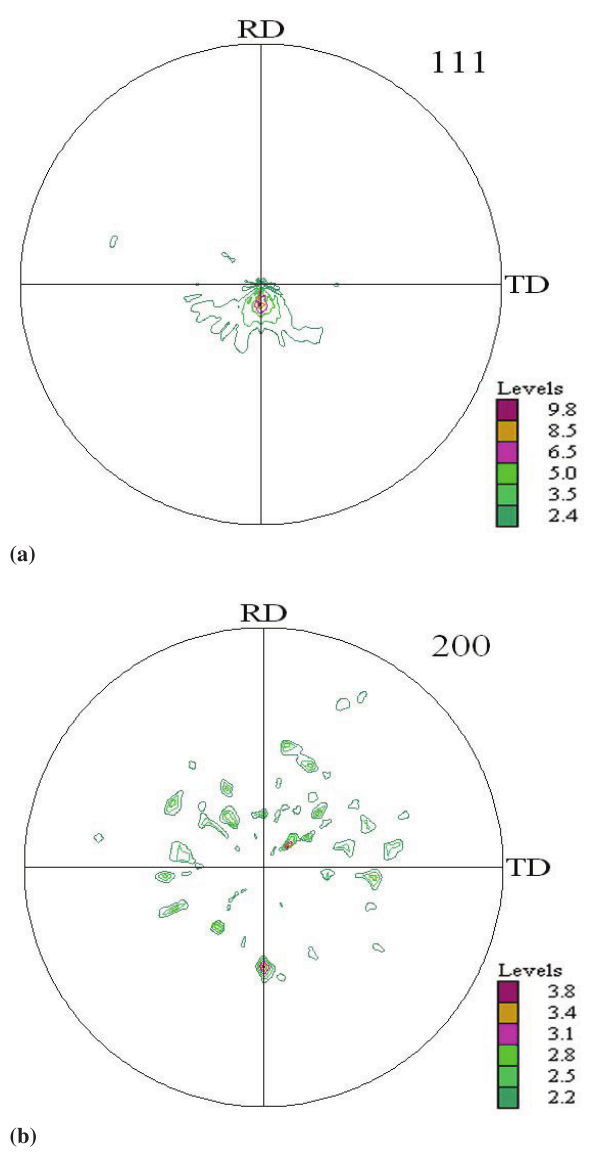
Figure 4. Pole figures for the 7YSZ coating deposited on a stationary (0 rpm = 1000°C) sample: (a) (111) pole and (b) (200)